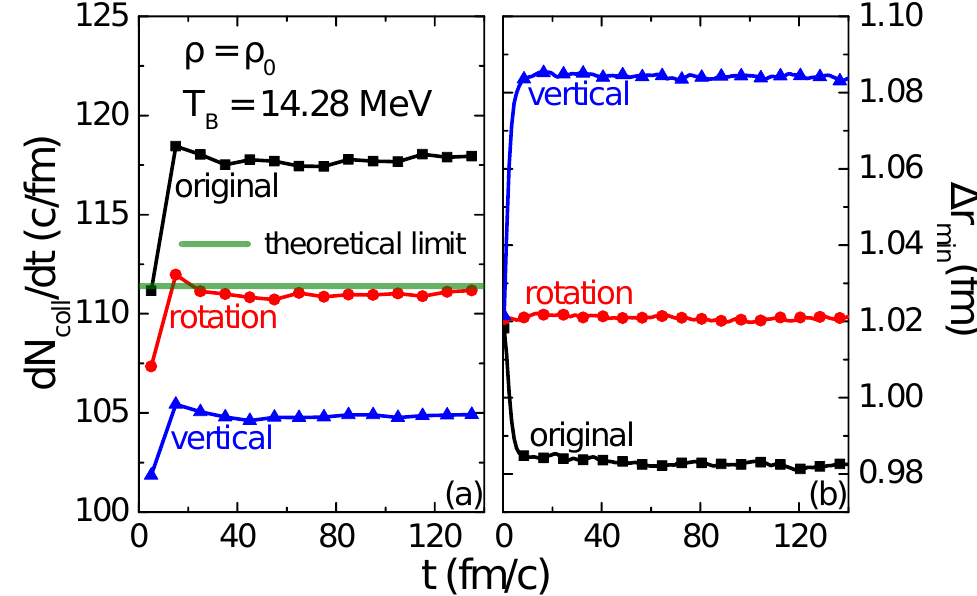
Figure 2. ( a ): Nucleon–nucleon elastic collision rates from three collision prescriptions in the box calculation compared with the theoretical limit; ( b ): Event average values of the neighboring distance for each nucleon from three collision prescriptions in the box calculation.